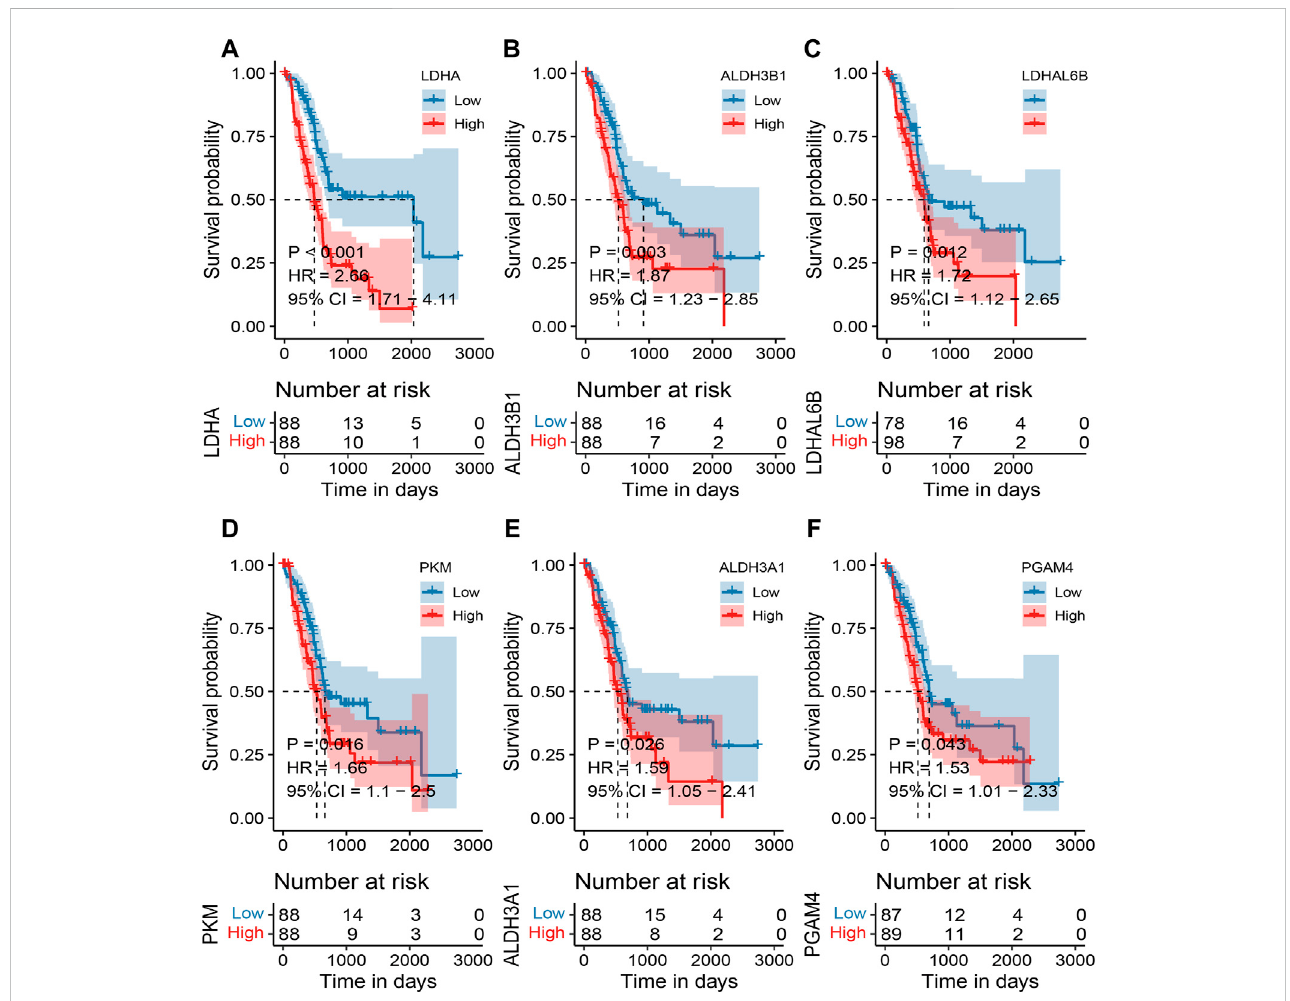
FIGURE 3 Survival analysis of MMRG core gene in pancreatic cancer patients. (A – F) Survival analysis of LDHA, ALDH3B1, LDHAL6B, PKM, ALDH3A1, and PGAM4, respectively ( p < 0.05).